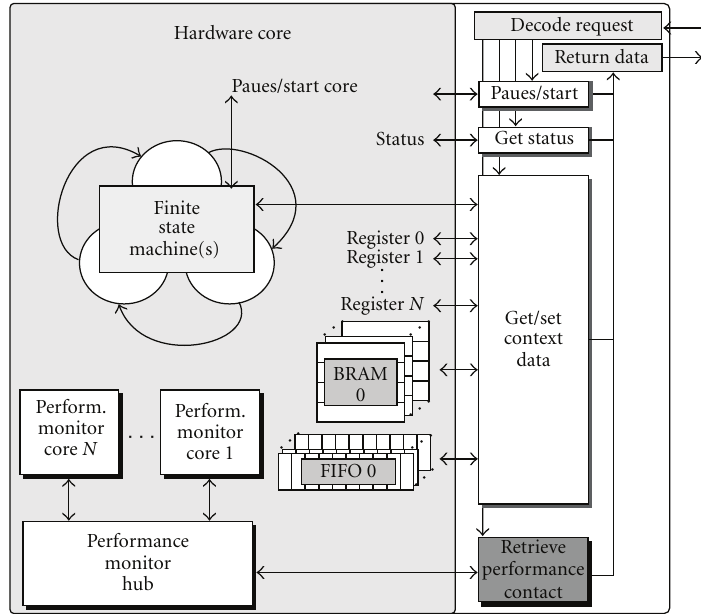
Figure 16: Block diagram of hardware core and its performance monitoring infrastructure.